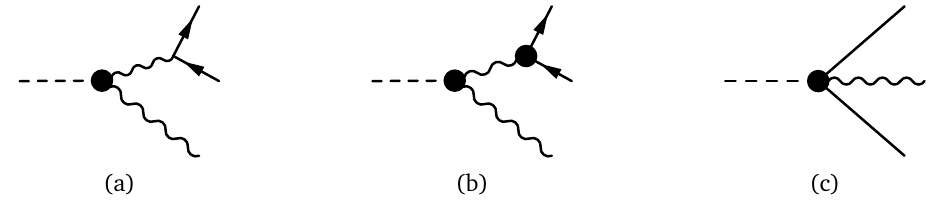
Figure 5: Diagrams contributing to the process H → ¯ (cid:96)(cid:96) in the SMEFT. The solid circle represents an insertion of an effective vertex. There is also the possibility that both the HV V and V ¯ (cid:96)(cid:96) vertex correspond to insertions of dimension-six operators giving an overall dimension-eight contribution. Diagram (a) is generated at orders 1 / Λ 2 and 1 / Λ 4 , (b) requires the insertion of two dimension-six operators and is therefore ( 1 / Λ 4 ) , and the four-point vertex of diagram (c) occurs first at dimension eight in O the SMEFT. We do not consider diagrams with a single operator insertion at the V ¯ (cid:96)(cid:96) vertex as this occurs only at